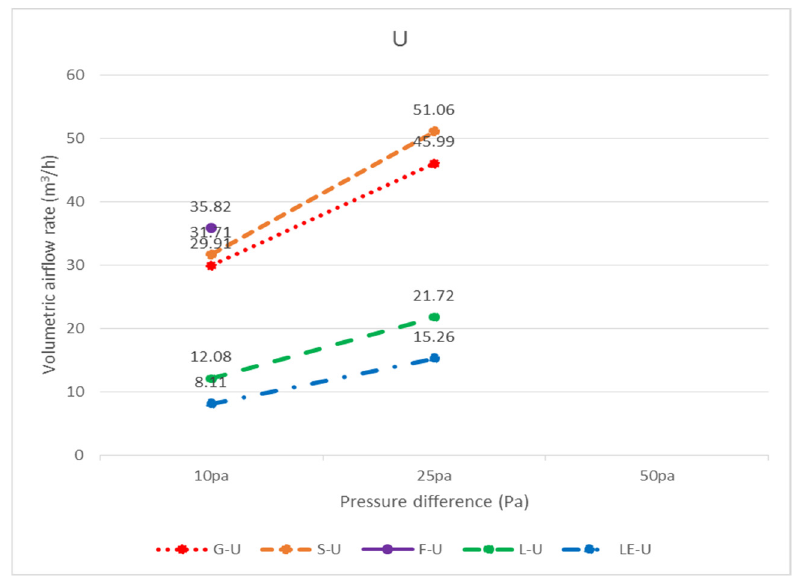
Figure 18. Unit leakage volume (m 3 /(h.m.)) of each specimen at each pressure difference with airflow bottom to top (U).